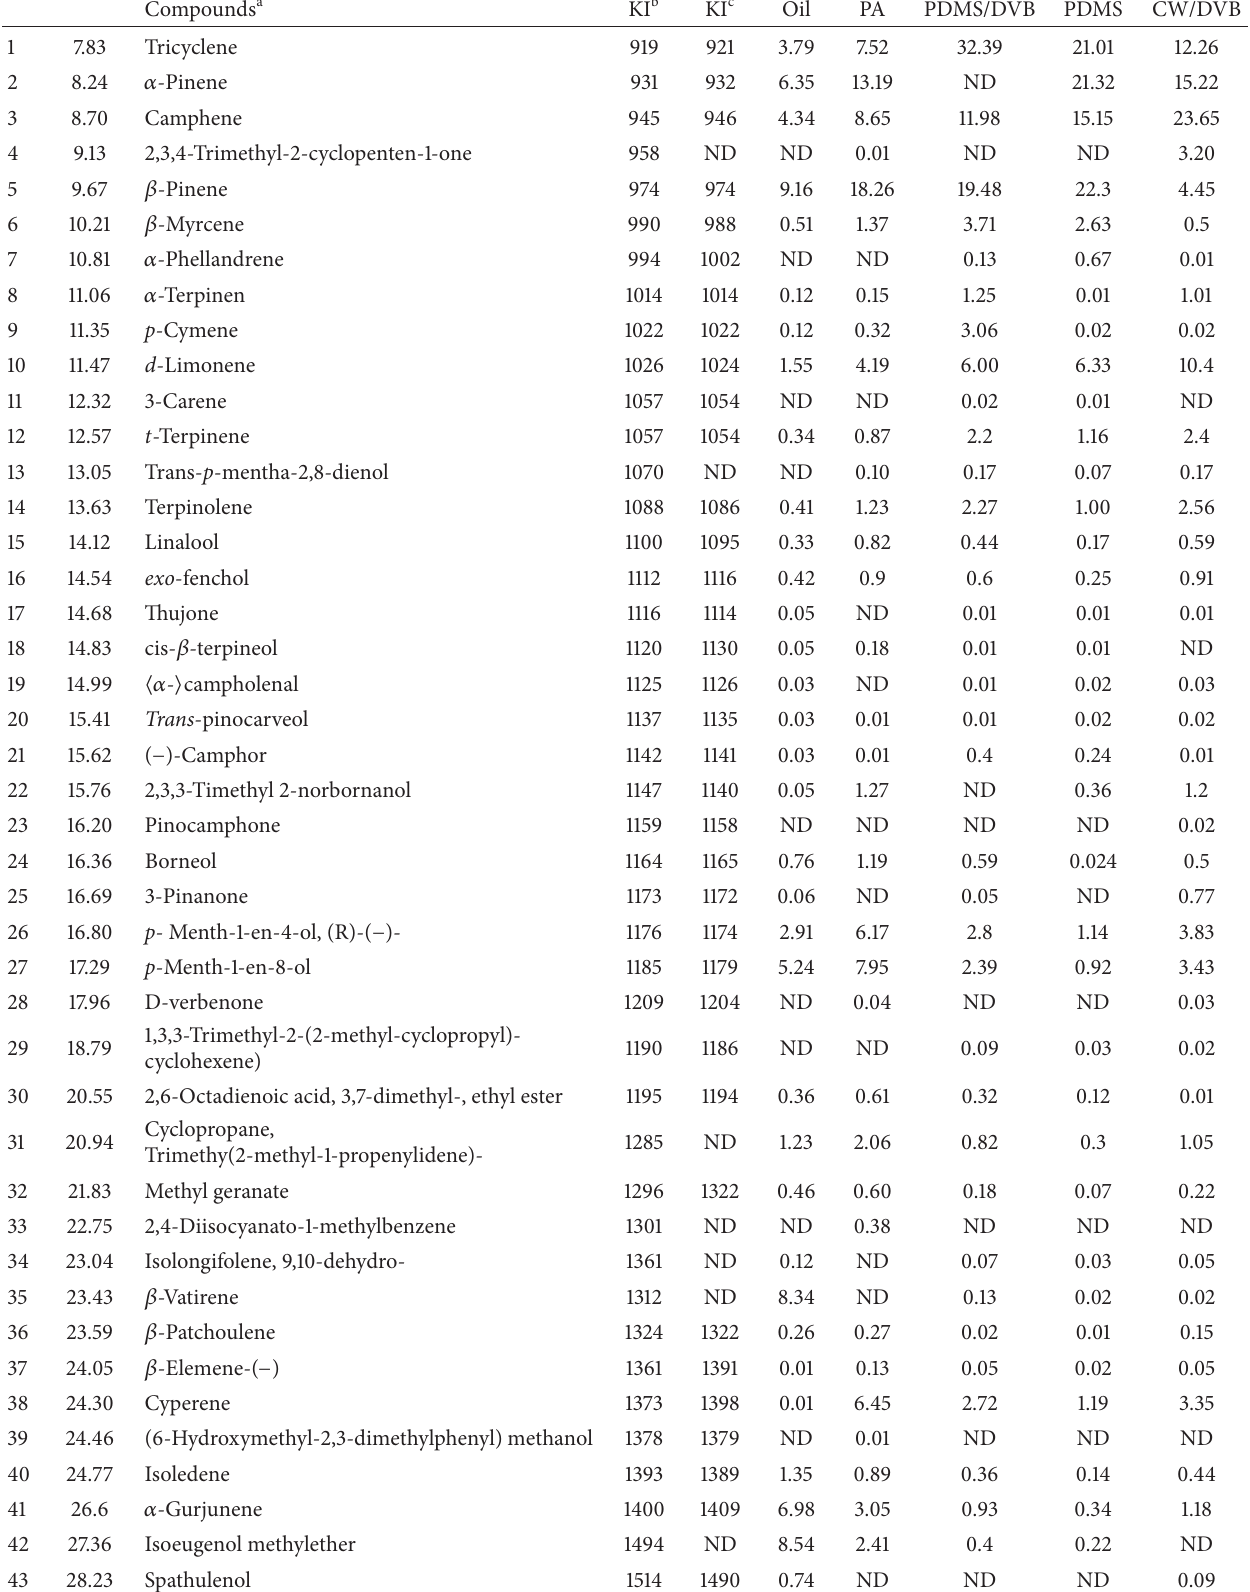
Table 1: Chemical composition of oil and volatile the J. ribifolia (Pohl) Baill identified by GC/MS and HS-SPME-GC-MS. Compounds